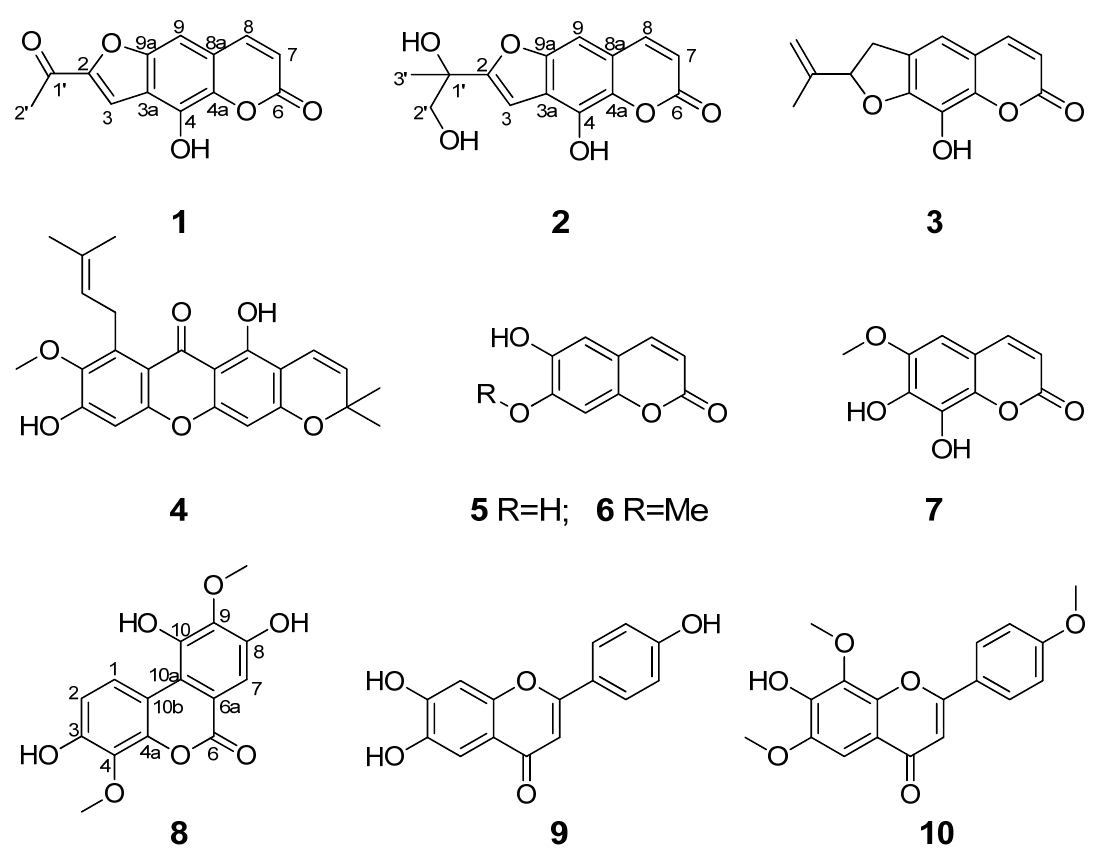
Figure 1. Chemical structures of compounds 1–10.